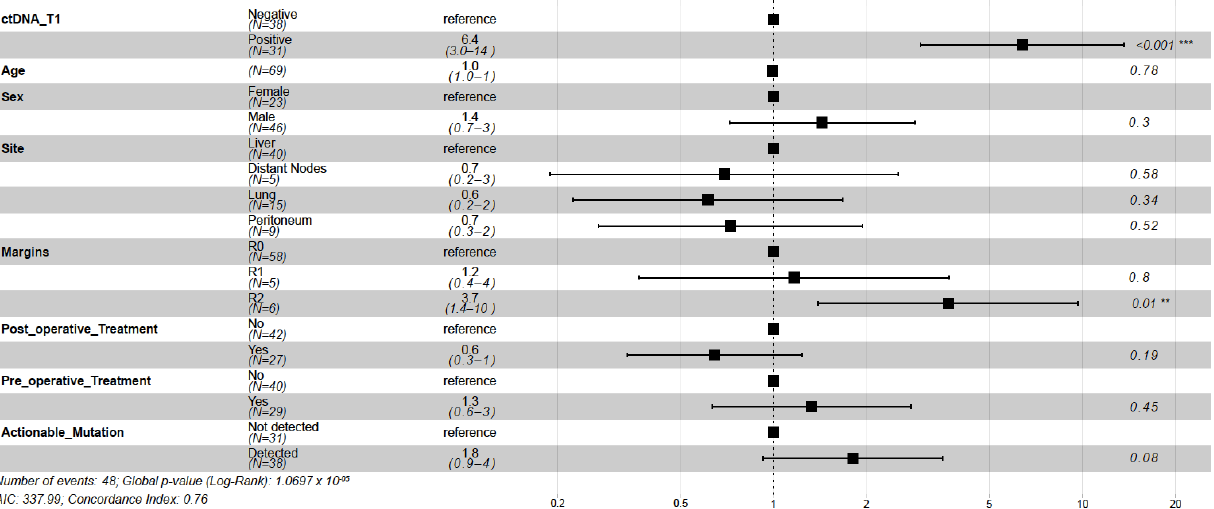
Figure 5. Forest plot depicting the multivariate analysis of prognostic factors and their association with DFS, as indicated by the Hazard Ratio. R2 resection margin had a significant association with disease-free survival ( p = 0.008). ctDNA detection at the postsurgical time point (T1) was the most significant prognostic factor ( p < 0.001). ** represents p < 0.01, *** represents p < 0.001.